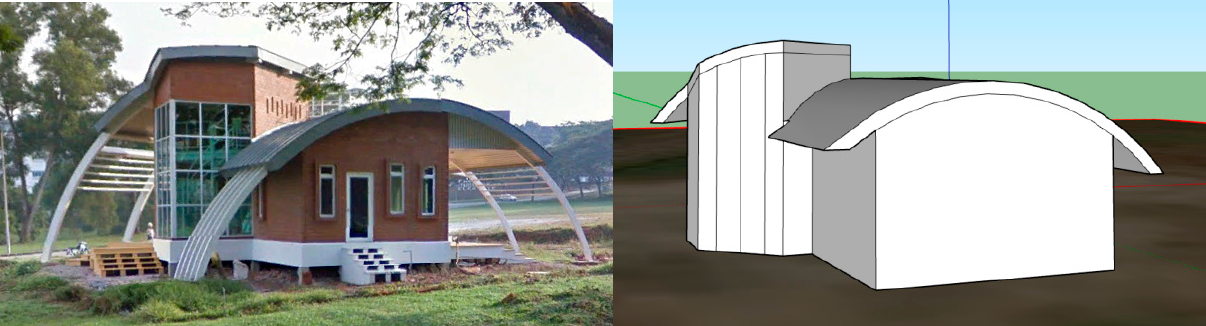
Figure 14. Example of real-world building and generalized LoD2 building.